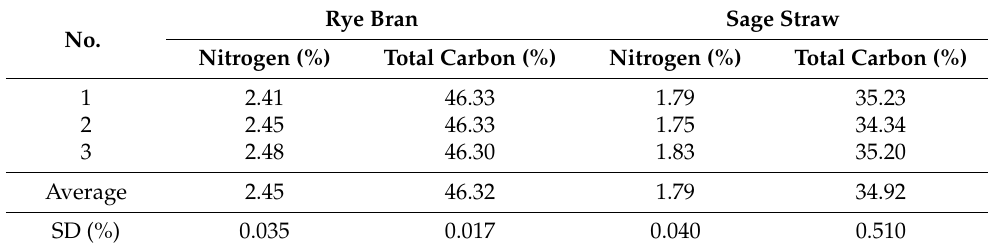
Table 4. Nitrogen and total carbon content of rye bran and sage straw.